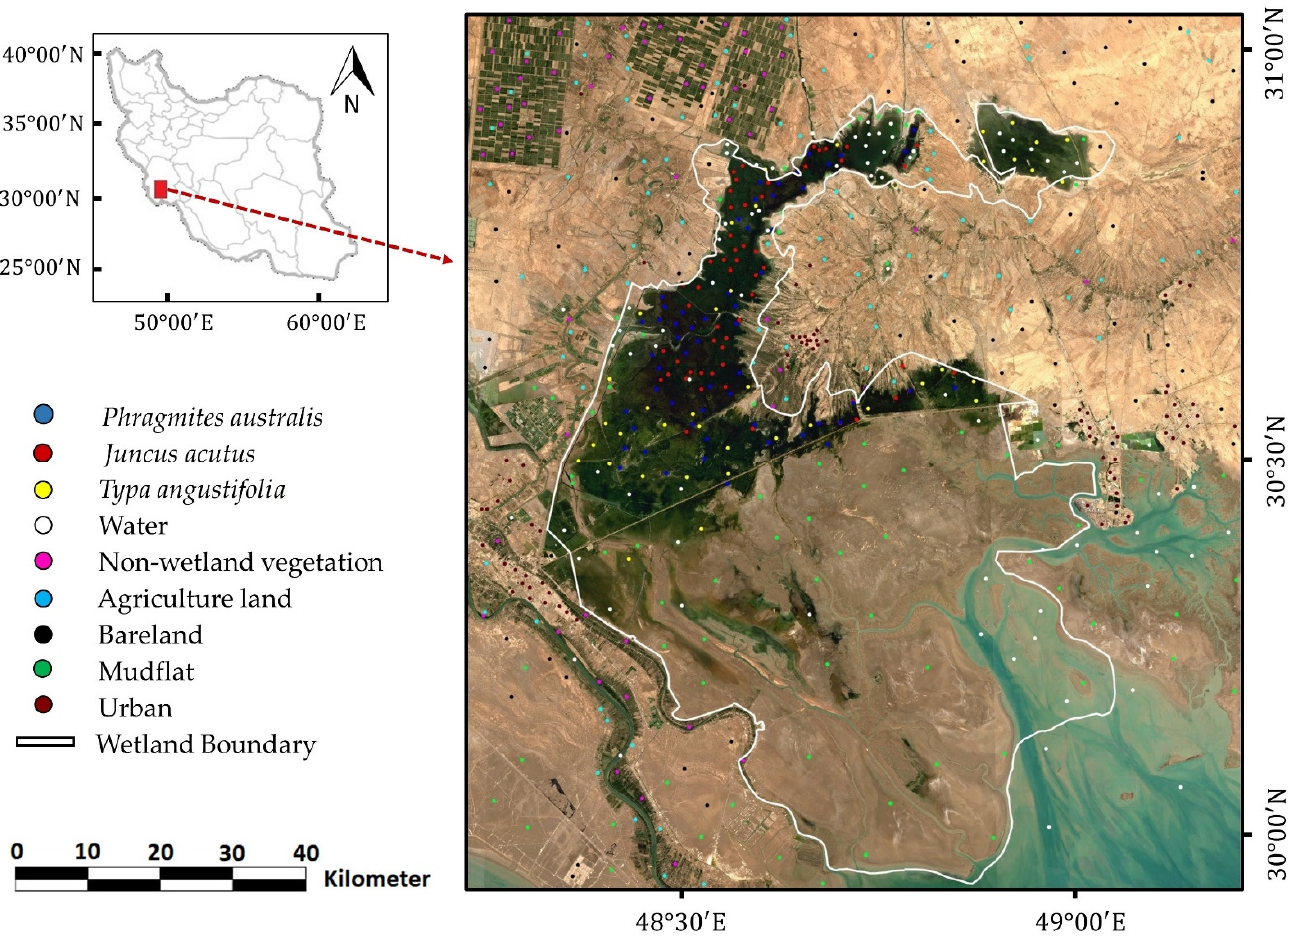
Figure 1. The geographical extent of the International Shadegan Wetland (ISW) and its surrounding areas, located in southwestern Iran, along with the distribution of the training samples across the study area, and the wetland boundary, outlined in white.